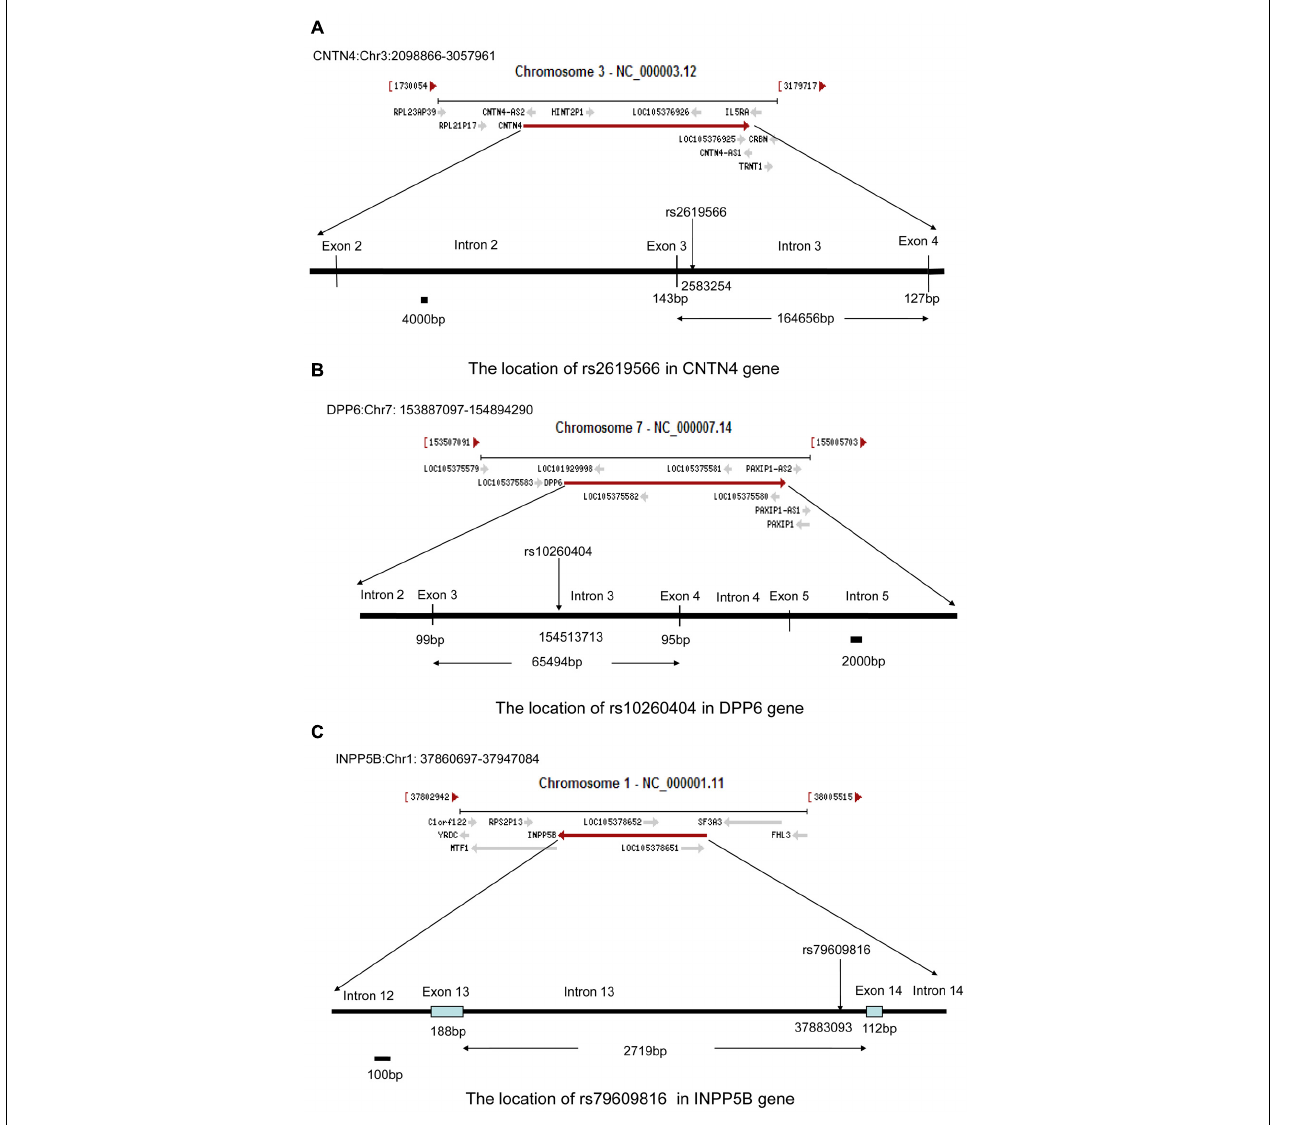
FIGURE 1 | Locations of rs2619566 in the CNTN4 gene, rs10260404 in the DPP6 gene, and rs79609816 in the INPP5B gene. (A) The rs2619566 is located upstream of intron 3, adjoined to exon 3, at position 2583254 of the CNTN4 gene on chromosome 3. (B) The rs10260404 is located in the middle of intron 3, at position 154513713 of the DPP6 gene on chromosome 7. (C) The rs79609816 is located downstream of intron 13, adjoined to exon 14, at position 37883093 of the INPP5B gene on chromosome